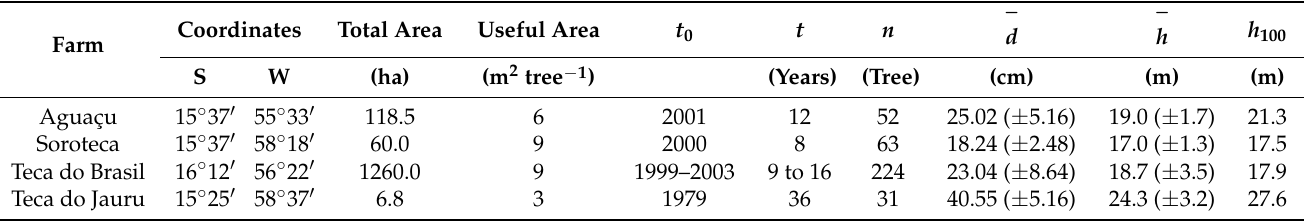
Table 1. Information on the stands of Tectona grandis L.f. used to study the stem forms, central-west region, Brazil.